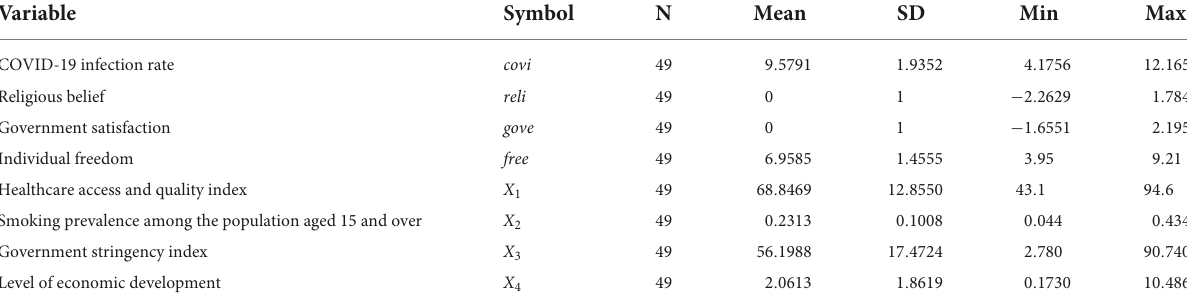
TABLE 2 Descriptive statistics of variables.